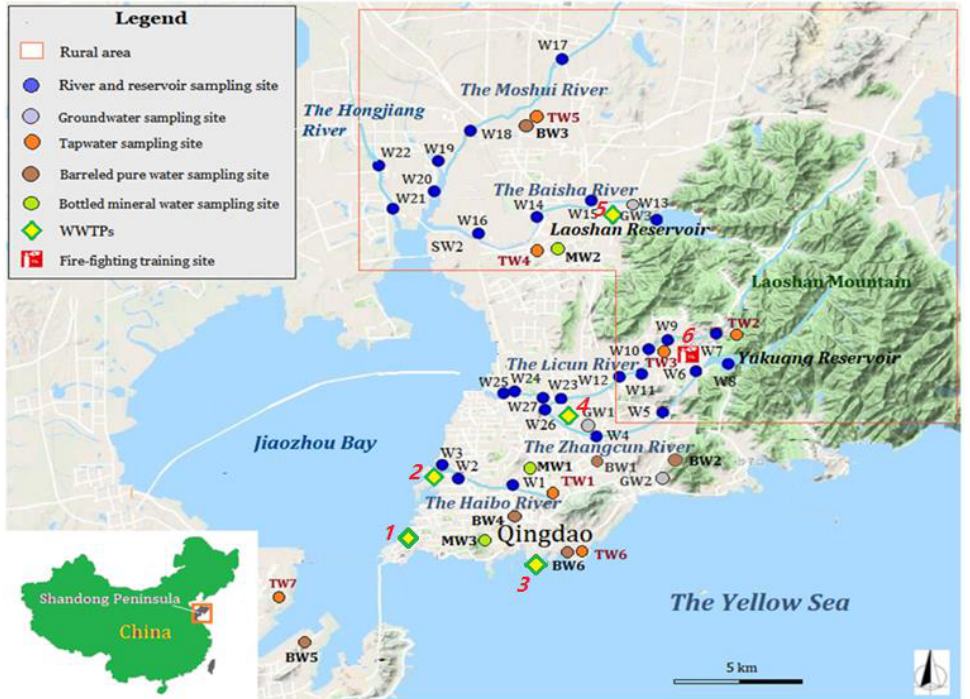
Figure 1. Map of the water sampling sites in Qingdao. The numbers in red italics denote the locations of potential anthropogenic contamination sources: (1) Qingdao Tuandao Sewage Treatment Plant. (2) Qingdao Haibo River Water Operation Co., Ltd. (Qingdao, China). (3) Qingdao Maidao Sewage Treatment Plant. (4) Qingdao Licun River Sewage Treatment Plant. (5) Jimo Sewage Treatment Co., Ltd. (Qingdao, China). (6) Qingdao Fire Training Base.